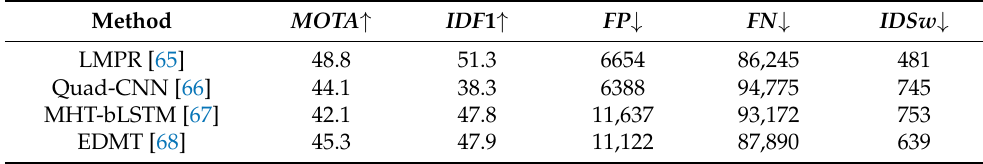
Table 1. Results of public detectors on MOT16 dataset (offline methods).